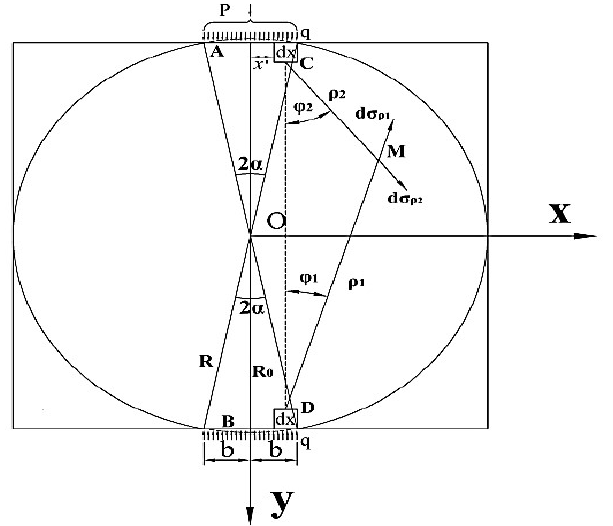
Figure 6. Schematic diagram of the internal stress calculation in the mechanical model of the indirect tensile test of the interlayer bond.